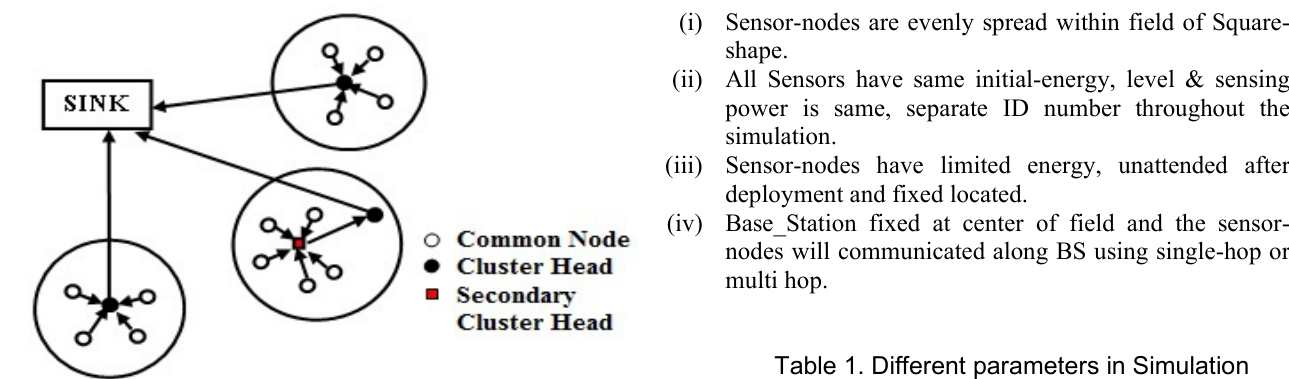
Table 1. Different parameters in Simulation